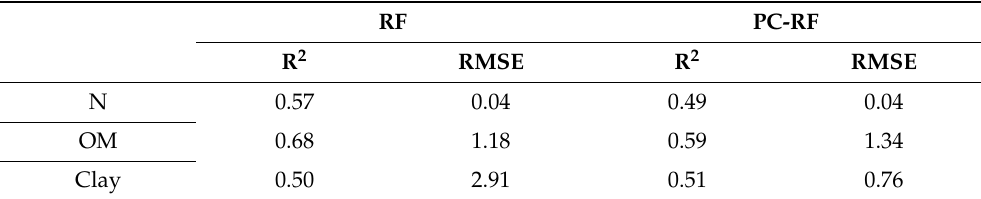
Table 2. Statistics of random forest regressions using no transformed spectral data (RF) and calcu- lating previously principal components (PC-RF).